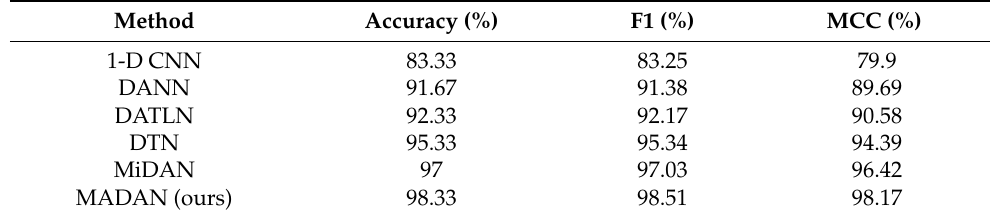
Table 5. Comparison research under various